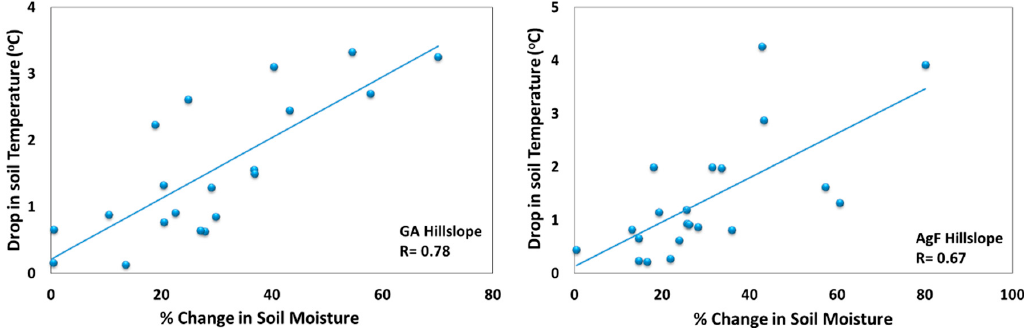
Figure 7. Correlation between percentage changes in soil moisture and drop in soil temperature during each rainfall event of grassed (GA) and agro-forested (AgF) hillslopes.